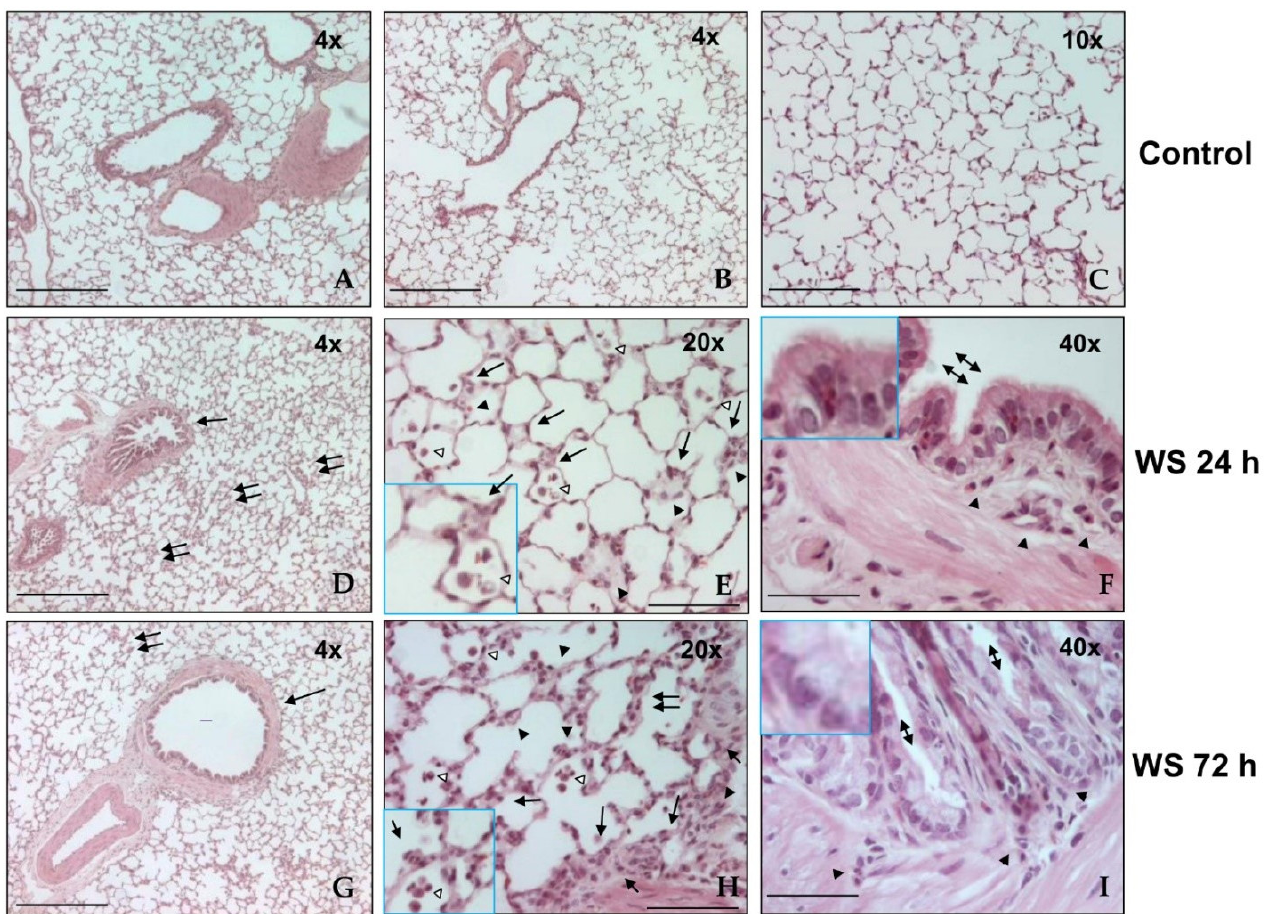
Figure 1. Representative photomicrographs of histological lung sections from WS-exposed guinea pigs and controls ( n = 8). Controls ( A – C ), after 24 h ( D – F ), and after 72 h ( G – I ) of exposure to WS. The bottom-left inserts in panels E and I show intralveolar and alveolar macrophages (empty arrow) and polymorphonuclear leucocytes (arrow). Upper-left inset in panels in F and I display goblet cell hyperplasia. Hematoxylin–eosin stain. Original magnification, panels A , B , D , and G , 4 × ; panel C , 10 × ; panels E and H , 2 × ; panels F and I , 40 × . Scale bars = 100 µ